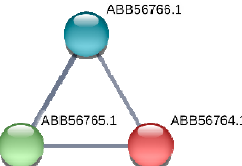
Figure 5. Network of ABB56764.1 protein ( Synpcc7942_0732 ) and its protein partners according to STRING (https://string-db.org) is shown. In this figure: protein ABB56765.1 ( Synpcc7942_0733 ) is the Phage portal protein, which belongs to the lambda family; protein ABB56766.1 ( Synpcc7942_0734 ) is putative DNA primase/helicase.